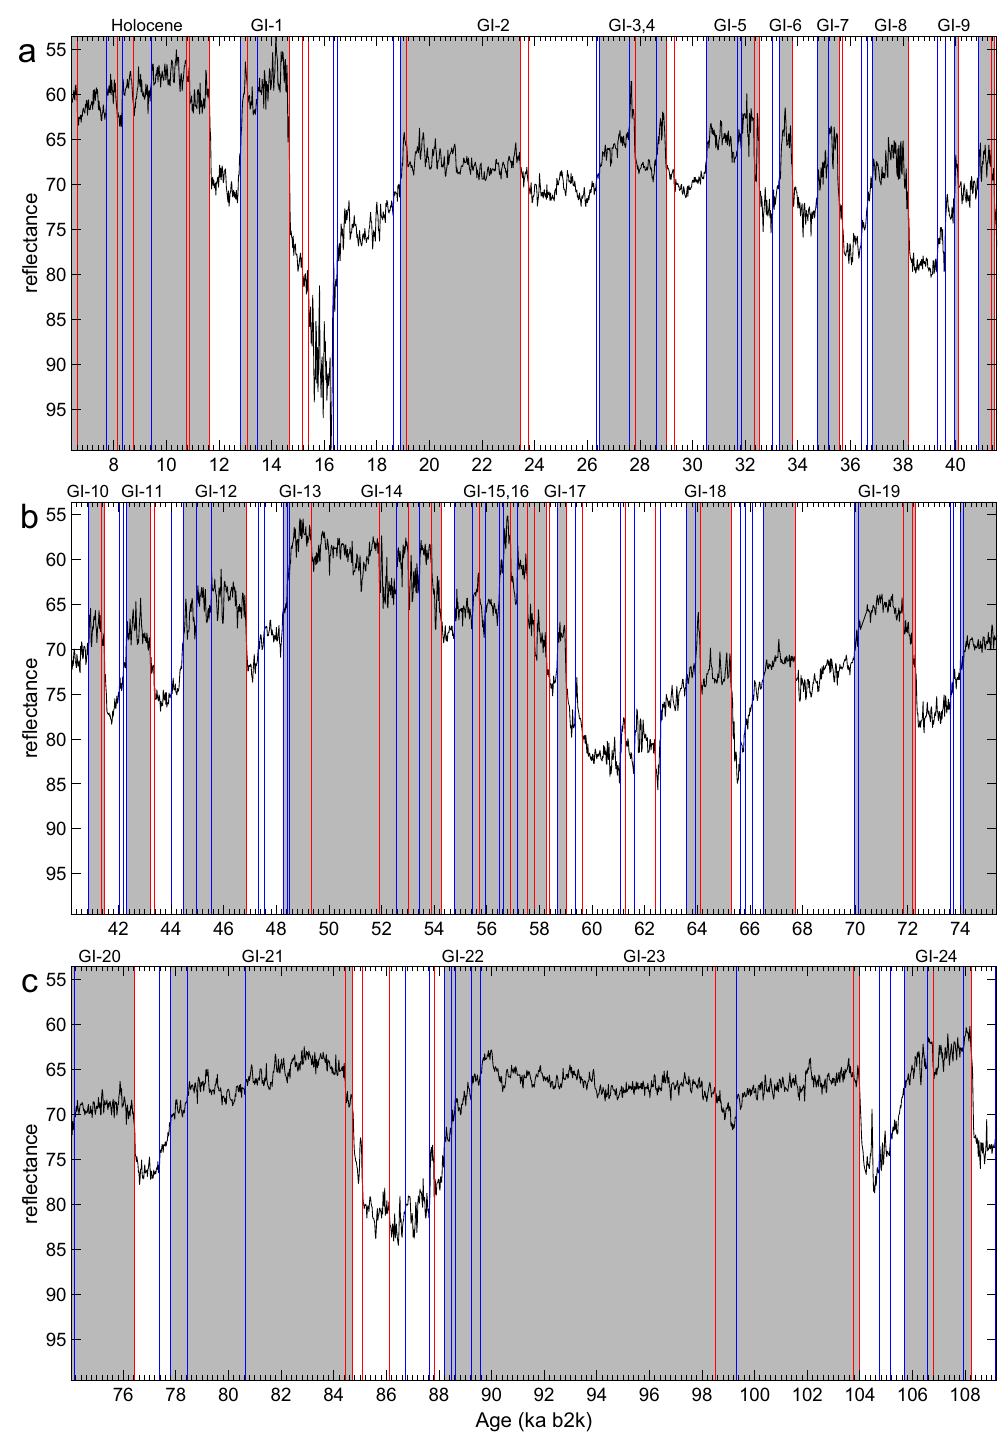
Figure 2. MD03-2621 marine sediment core: ( a ) 6.4–41.6 ka b2k; ( b ) 40.2–75.4 ka b2k; and ( c ) 74–109.2 ka b2k. The black solid line is the core reflectance 64 , with the vertical axis reversed. Vertical lines represent transitions detected by the KS test of Bagniewski et al. 19 , with colors indicating the direction of the jumps. In this figure, red lines represent a warming event, while blue lines represent a cooling event. In other figures, the meaning of the colors may vary. Grey bars denote warm episodes. Note that all time axes in this paper follow the geological custom of pointing into the